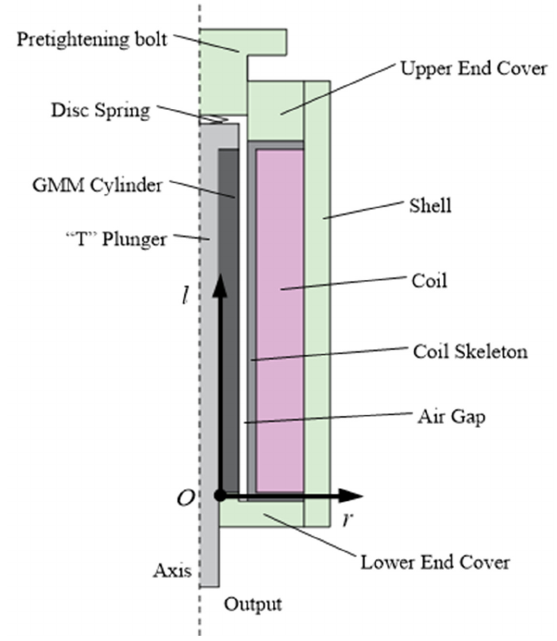
Figure 6. Establishment of coordinate system.